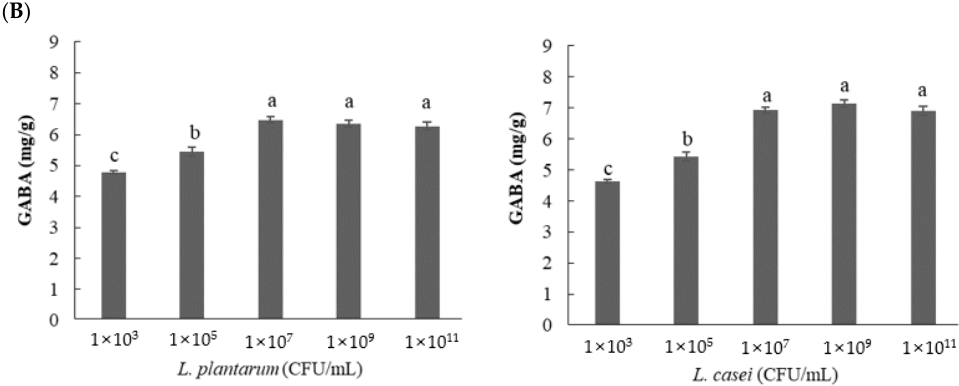
Figure 4. Glutamic acid ( A ) and GABA ( B ) contents of Oryza sativa extracts depending on the inoculated cell number of Lactobacillus strain. Each bar is the mean ± standard deviation of the results from three different analyses ( n = 3). Bars with different letters (a–c) indicate significant differences at p < 0.05 using Duncan’s multiple range test.